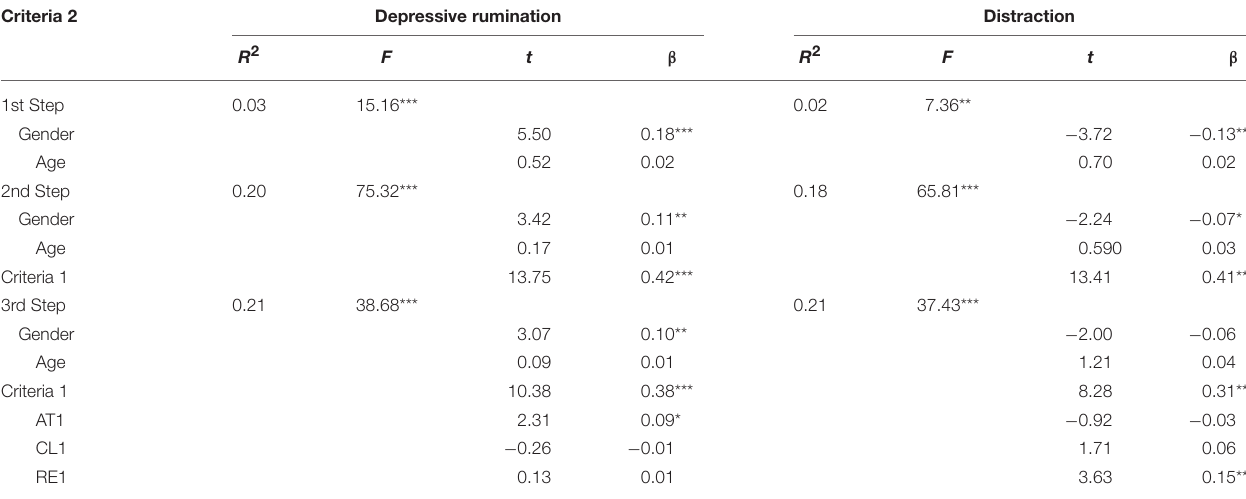
TABLE 3 | Stepwise regression analyses for responses to negative affect as criteria variables. Criteria